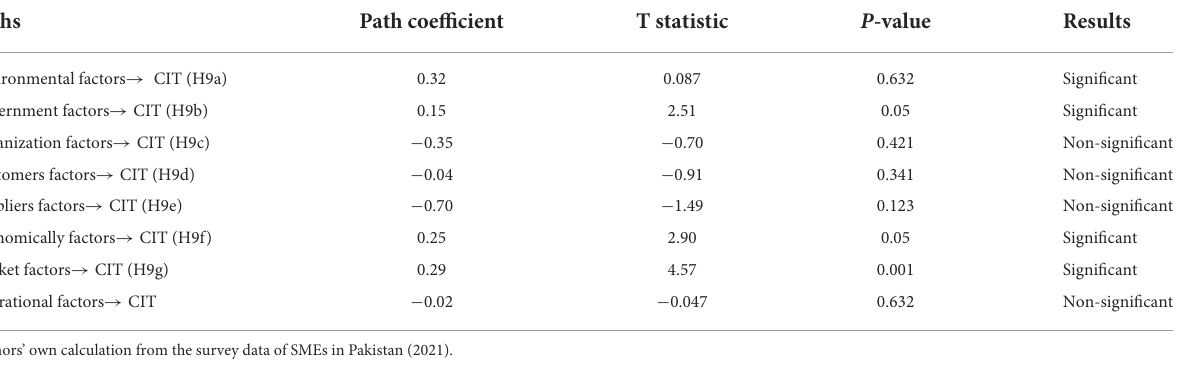
TABLE 9 Results of estimating the moderation analysis.